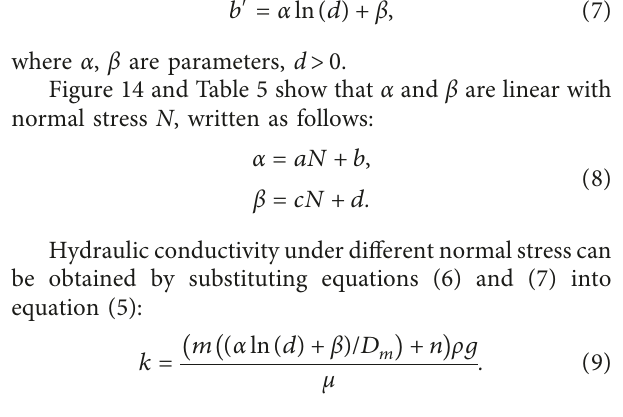
Figure 13: Change in fissure width b placement d